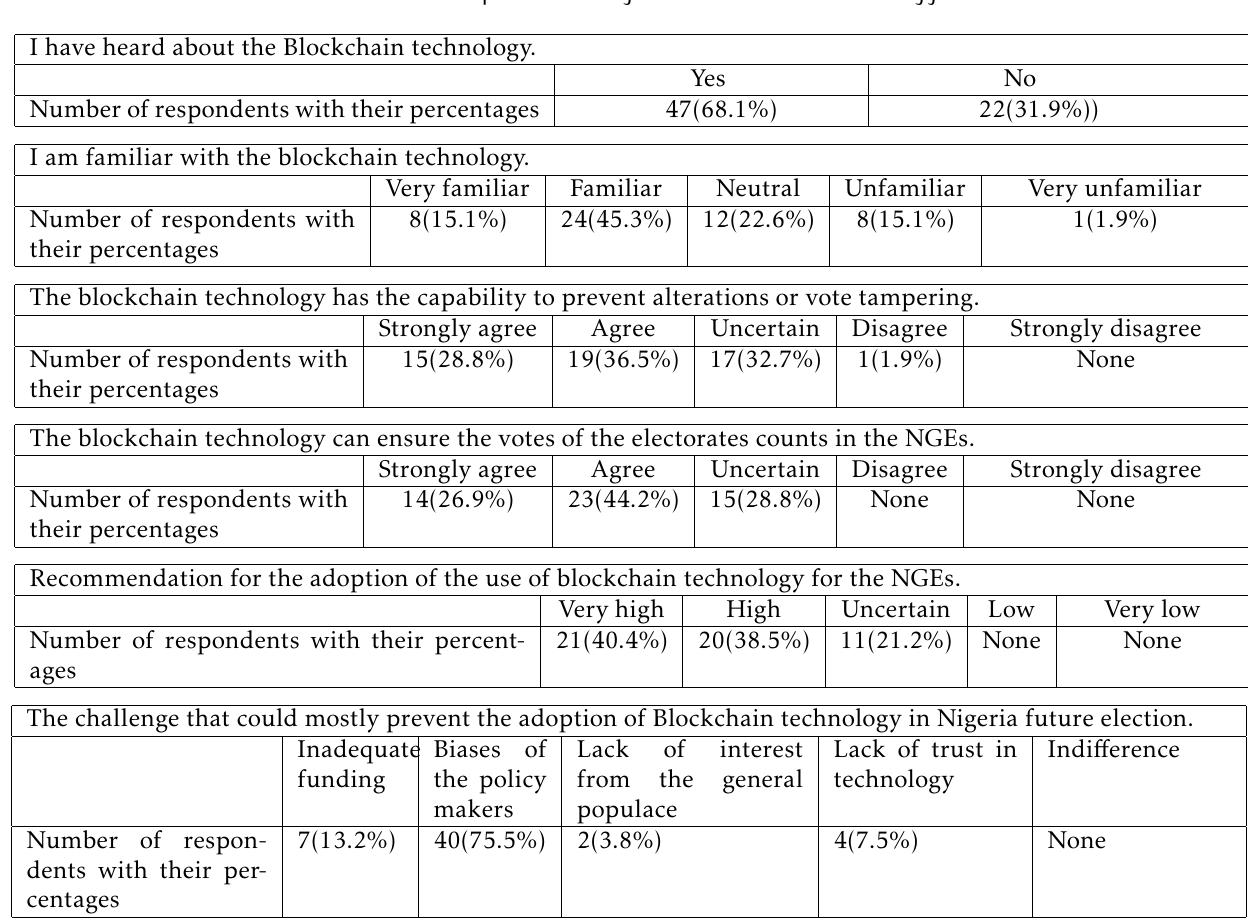
Table 5. Participants’ knowledge related blockchain